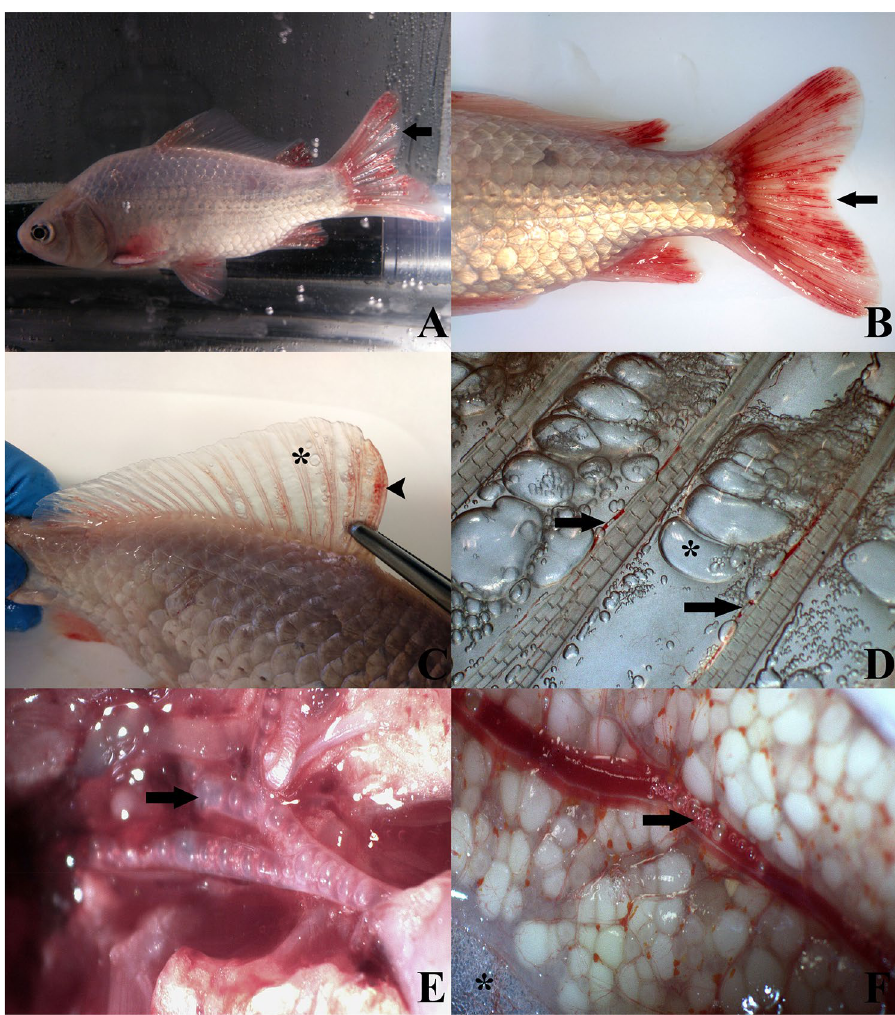
Figure 7. Macroscopic appearance of the 18-h fish group. ( A ) Fish alive inside the pressurized aquarium in the last hours of the experiment. Emphysema, congestion, and hemorrhages are observed in all fins. ( B ) External examination of the fish after euthanasia. Presence of the similar lesions observed in vivo. ( C ) Dorsal fin with the presence of emphysema (star) and multifocal hemorrhages (arrowhead). ( D ) Detail of dorsal fin with gas bubbles in blood vessels (arrows) and emphysema (star). ( E ) Ventral aorta at its exit from the bulbus arteriosus filled with gas. ( F ) Gas bubbles circulating in the gonadal vessel and presence of emphysema of the adjacent adipose